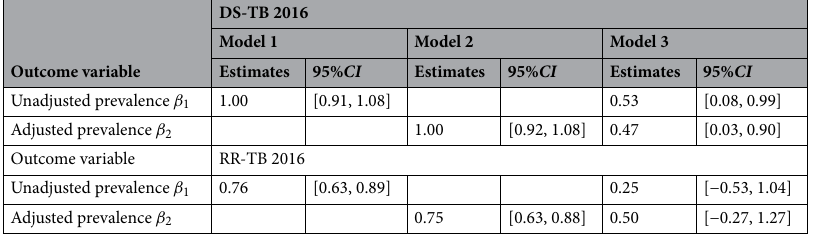
Table 2. Association between future annual drug-susceptible tuberculosis (rifampicin-resistant tuberculosis) incidence and baseline drug-susceptible tuberculosis (rifampicin-resistant tuberculosis) prevalence and migration-adjusted drug-susceptible tuberculosis (rifampicin-resistant tuberculosis) prevalence. We estimated municipality-level (n = 234) migration-adjusted prevalence using tuberculosis burden from South Africa’s National Health Laboratory Service (NHLS) database and cross-municipality migration rates from the 2016 South African Community Survey. We have matched the survey data on the demographics among people with laboratory-diagnosed tuberculosis. We used prevalence:notification ratio from the 2018 South African national tuberculosis prevalence survey to convert laboratory-diagnosed tuberculosis cases by municipality into prevalence. Models 1 and 2 are regression models with baseline tuberculosis prevalence only and migration- adjusted prevalence only respectively, and model 3 has both